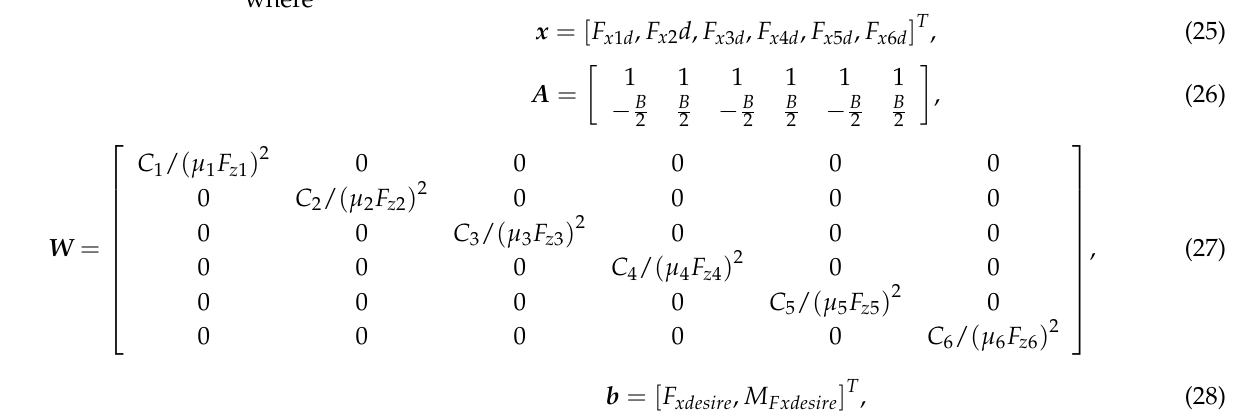
Table 1. Parameters of the experimental platform.